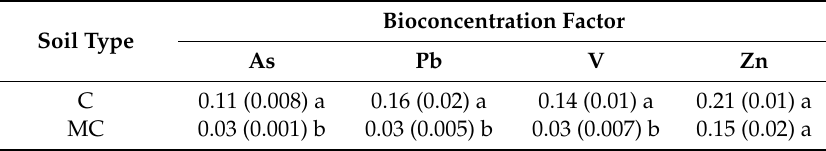
Table 6. Bioconcentration factor (BCF) calculated for roots (n = 4) of hemp plants ( Cannabis sativa L., cv. Codimono) after 90 days of growth in a greenhouse in pots filled with soil sampled in two di ff erent sites (C and MC) in the “Valle del Sacco” area (Lazio Region, Central Italy). In each column, mean values (n = 4 ± SE) are reported. Di ff erent letters indicate significantly di ff erent values (t-test, p ≤